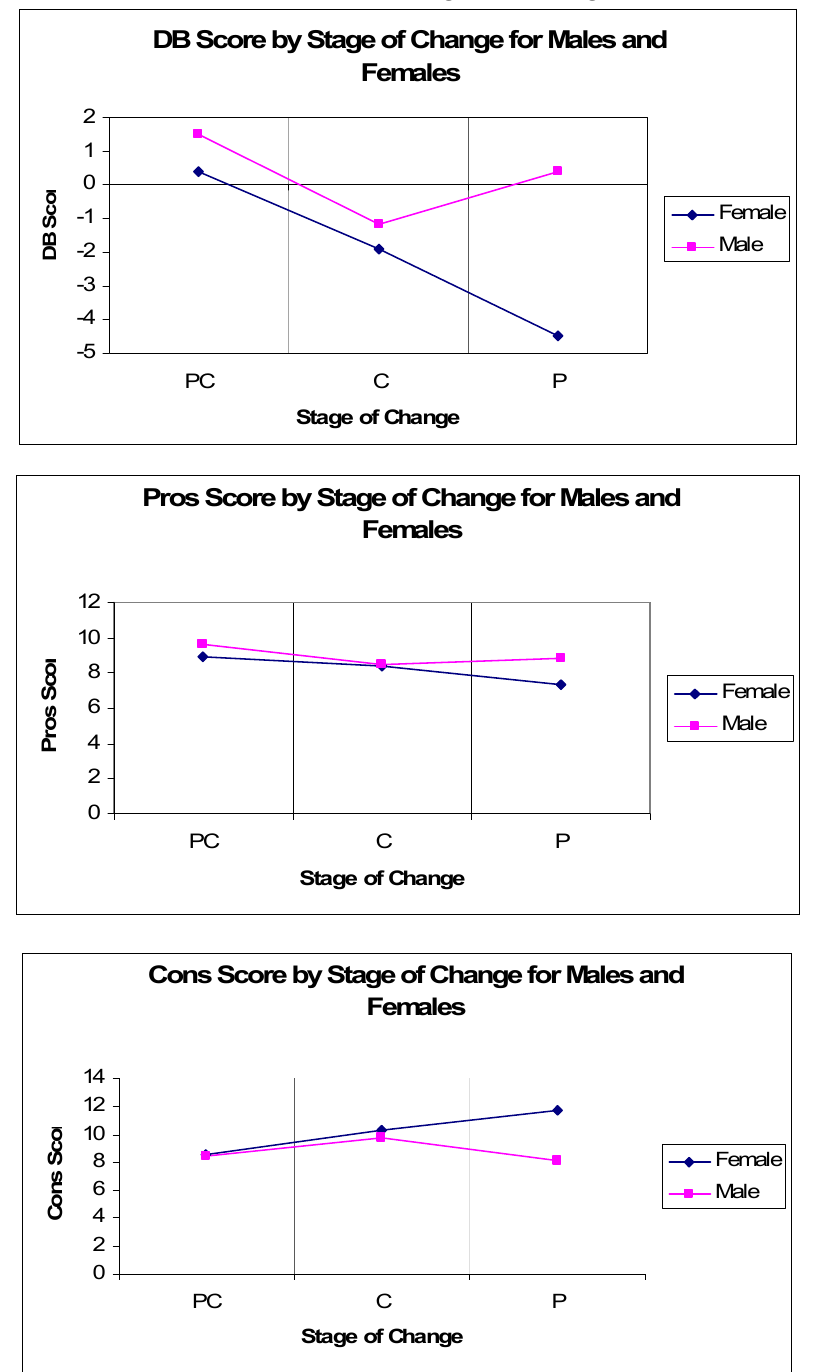
Figure 2. Decisional Balance across the Stages of Change for Males and Females. DB Score by Stage of Change for Males and